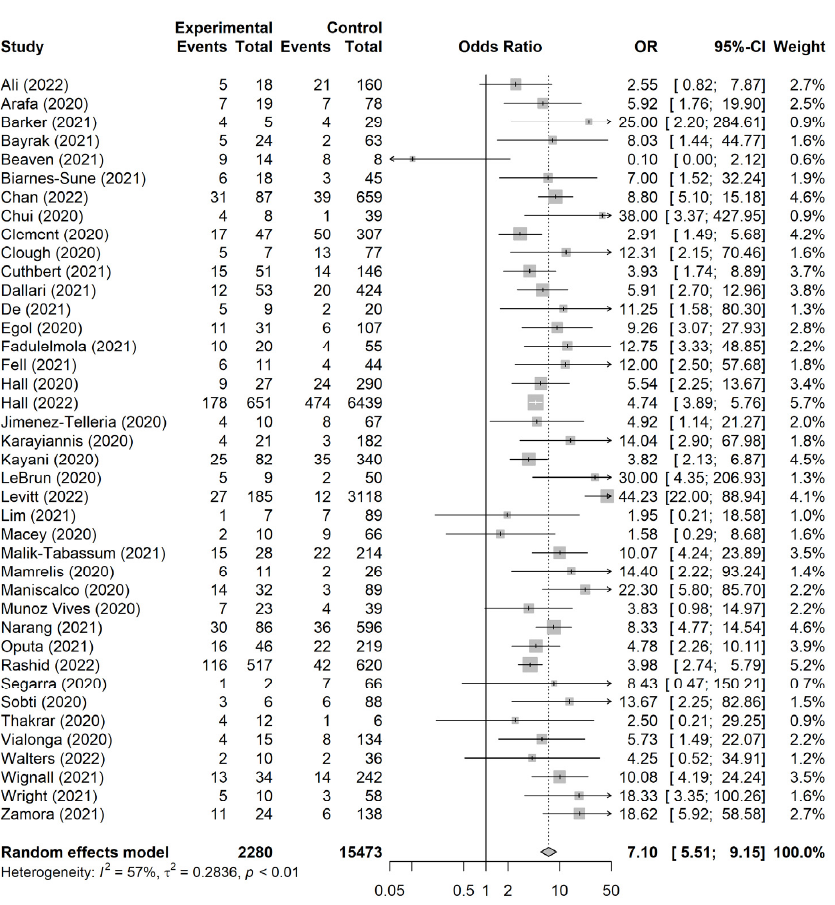
Figure 3. Forest plot for meta-analysis of patients with hip fractures with and without COVID-19 [11,20–58]. Table 2. Subgroup analysis for the 30-day mortality of hip fractures in patients with and without